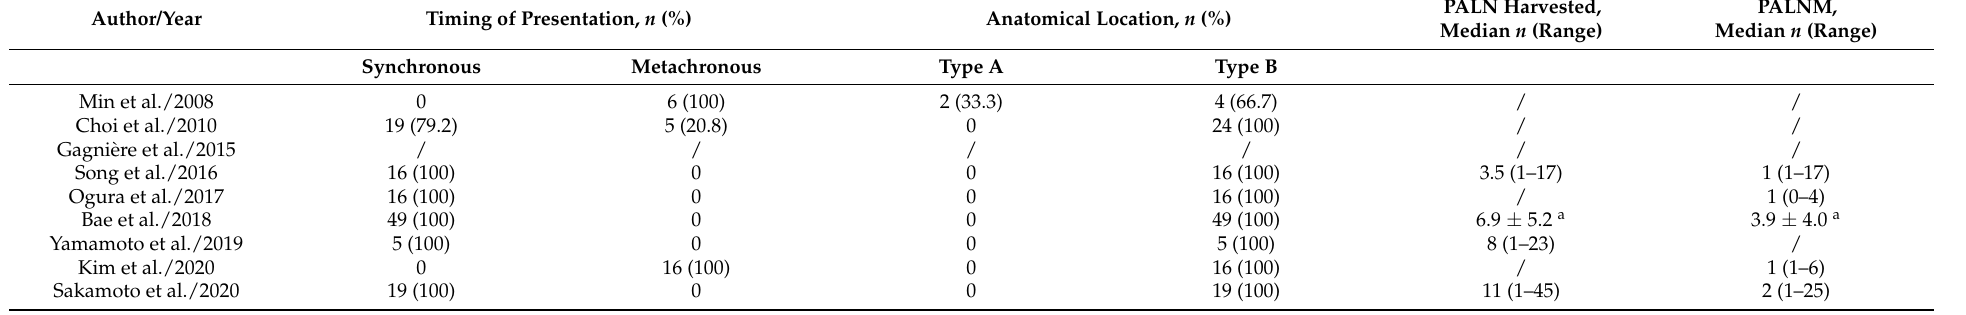
Table 3. PALN metastases.